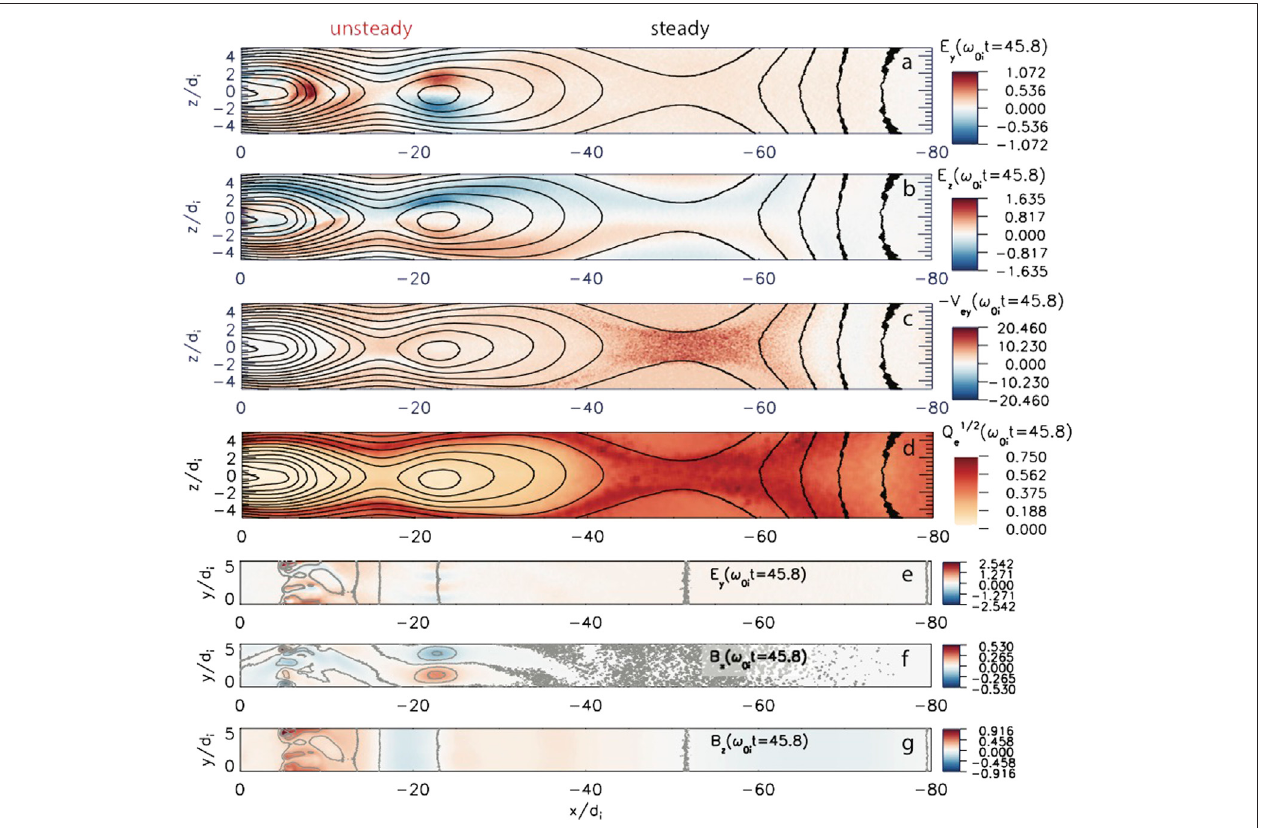
FIGURE 13 | Steady and unsteady reconnection regions in weakly driven magnetoatail at the moment ω 0 i t (cid:1) 45 . 8 corresponding to Figure 12E . (A – D) The distributions in the plane y (cid:1) 2 . 5 d i of the electric fi eld components E y and E z , the electron bulk fl ow velocity (cid:1) − V ey and the electron agyrotropy parameter marking the localization of the electron diffusion region (in the latter case, to reduce noise in simulation outputs, the original numerical distributions are averaged over 20 × 20 grid cells). (E – G) The distributions of the electric fi eld E y and the magnetic fi eld components B x and B z in the neutral plane z (cid:1) 0.